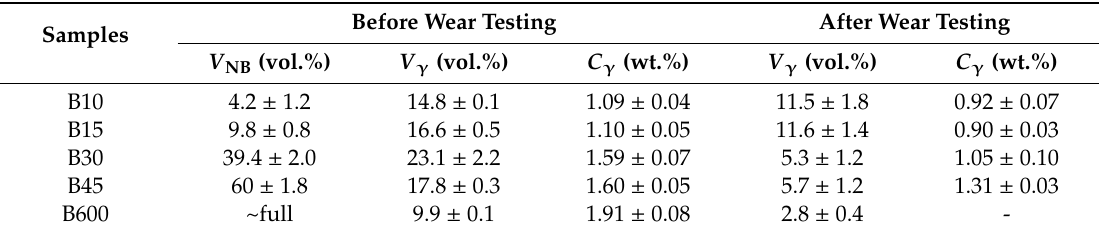
Figure 2. SEM images of samples used for wear testing: ( a ) B10, ( b ) B15, ( c ) B30, ( d ) B45, ( e ) B600, and ( f ) TEM images of B45 showing a mixture of NB, M, C, γ B and in the corner are details of NB. NB represents nanobainite, M martensite, C carbides, GB grain boundary, γ B blocky retained austenite, γ F film-like retained austenite, and BF bainite ferrite, respectively. Table 2. Volume percentages of nanobainite ( V NB ) and retained austenite ( V γ ), and the average carbon content in retained austenite ( C γ ) of all samples before and after wear testing (values are means ± standard deviation).